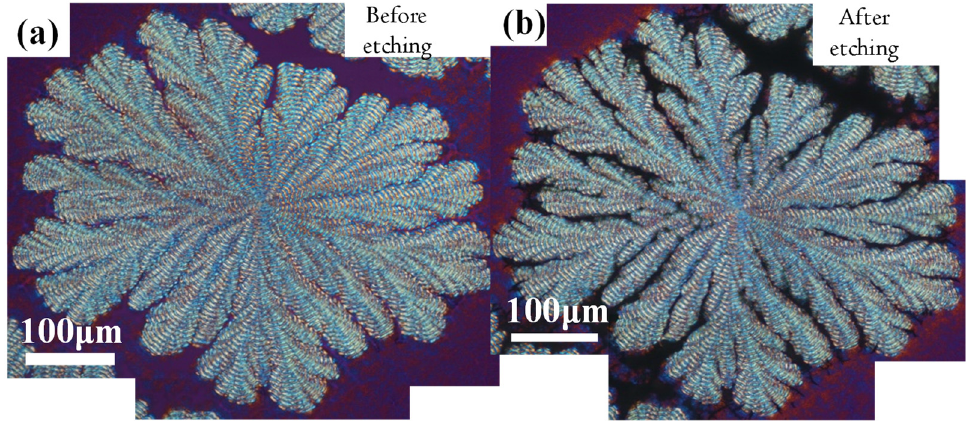
Figure 2. Dendritic-banded PPDO spherulites crystallized from PPDO/PVPh = 75/25, at T c = 78 °C. Specimens ( a ) before etching and ( b ) after methanol-etching for 20 min.